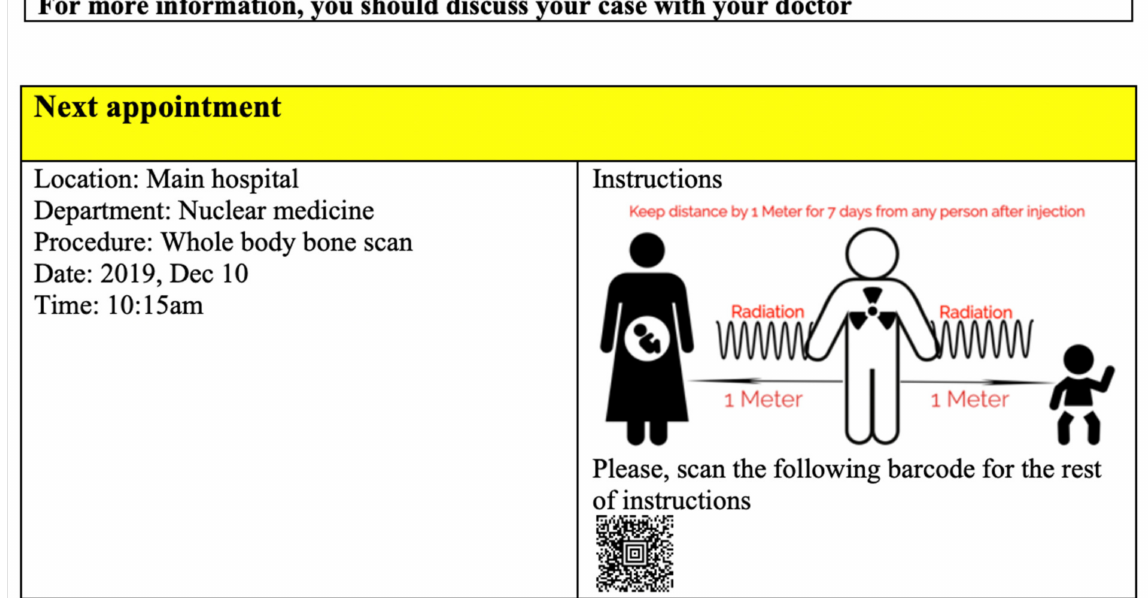
Figure 5. Revised design of the MRI lumbar spine